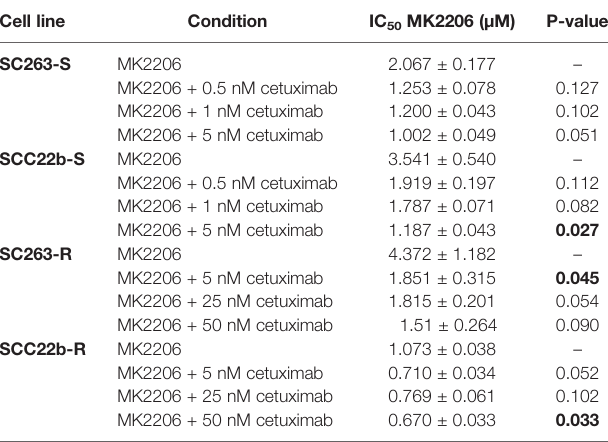
TABLE 3 | IC 50 and standard errors for HNSCC cell lines after treatment with cetuximab for 168h with MK2206 added during the last 72h of treatment. Cell